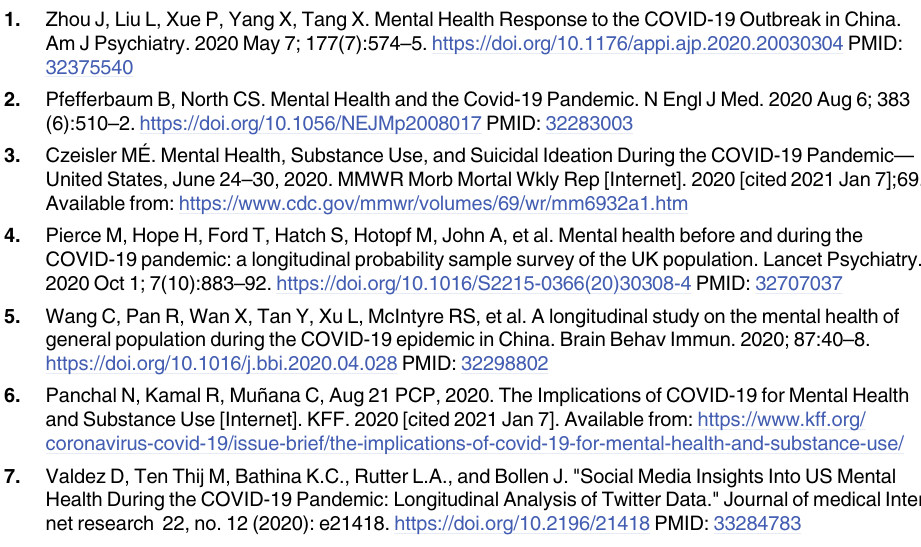
S2 Table. Regression model with all predictors. Base model with additional population inde- pendent variables. We then performed an OLS regression predicting VADER scores on con- firmed COVID-19 cases per 1,000 people in 10 metropolitan cities. We also included the following IVs (1) city population (i.e., the total number of people residing in each metropolitan area), (2) population density (i.e., a measurement of population per unit area, or exceptionally unit volume), and (3) city demographics (i.e., percent white versus non-white). Confirmed COVID-19 cases ( β = -.012, 95% CI [-.02, -.004], p = .006) and City Demographics ( β =